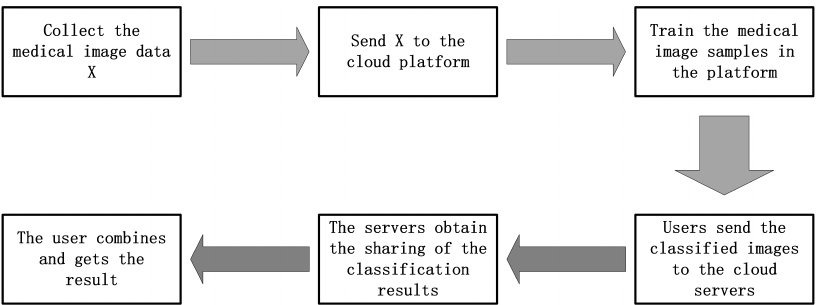
Figure 5. The workflow of our privacy-preserving outsourcing medical image